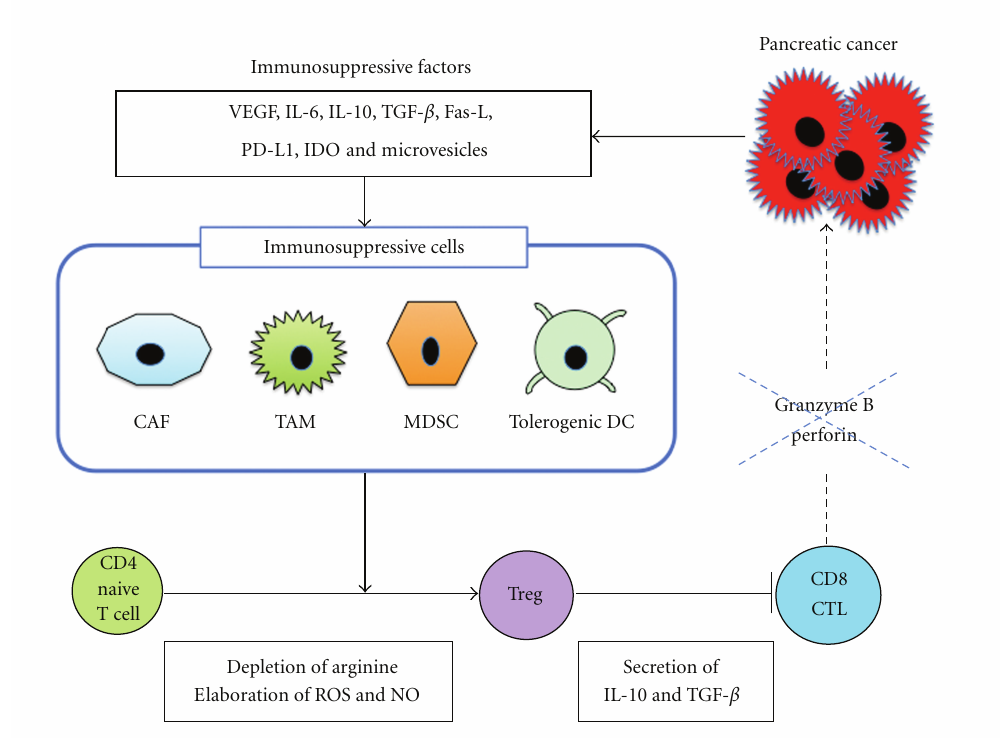
Figure 3: Pancreatic cancers induce an immunosuppressive tumor microenvironment. Pancreatic cancer cells secrete various immuno- suppressive factors such as VEGF, IL-6, IL-10, TGF- β , Fas-L, IDO, PD-L1, and microvesicles, all of which promote the accumulation of TAM, MDSC, or tolerogenic DC. These immunosuppressive cells inhibit antitumor immunity by various mechanisms, including depletion of arginine and elaboration of ROS and NO. An immunosuppressive tumor microenvironment induced by pancreatic cancers suppresses CD8+ CTL function through secretion of IL-10 and TGF- β from Treg cells. All contribute to pancreatic cancer-induced immune